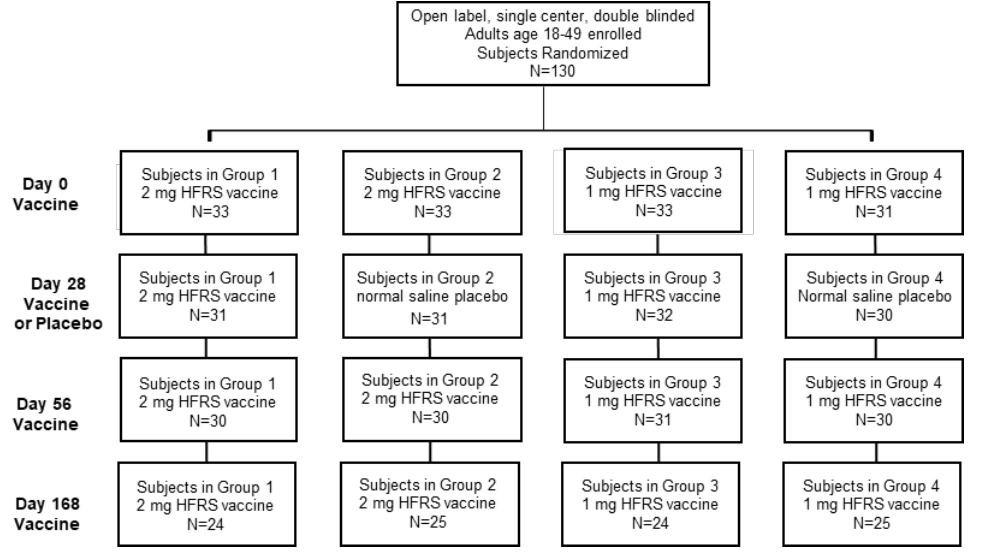
Figure 1. Clinical trial.